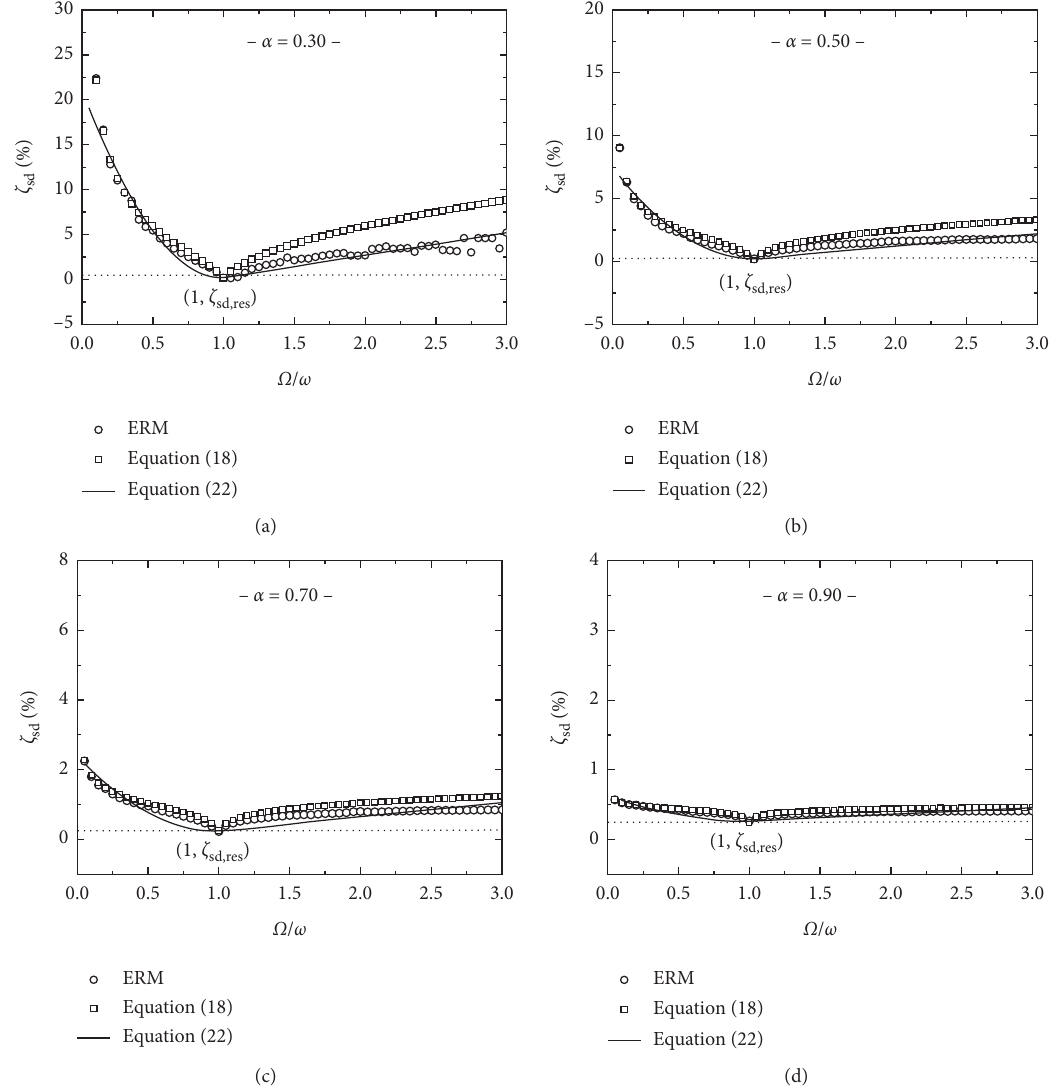
Figure 9: ADR ( ζ sd ) vs. frequency ratio ( Ω / ω ): (a) α